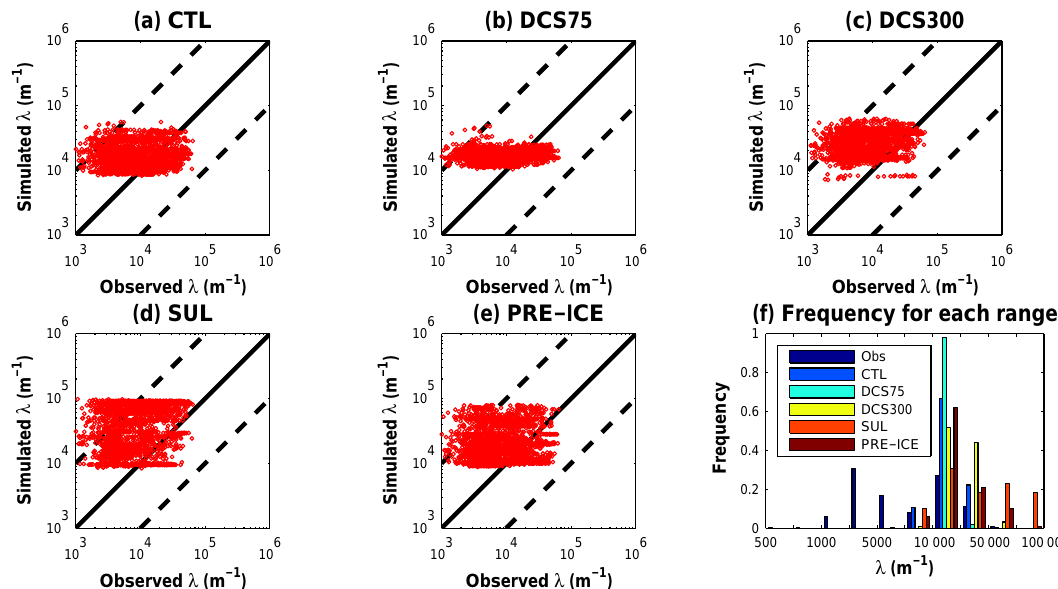
Figure 6. (a–e) Scatterplot of observed versus simulated slope parameter ( λ) of the gamma size distribution function for each experiment, and (f) the frequency of λ for each range. Note that all the comparisons are restricted to the cases when the model captures observed ice clouds ( T ≤ − 40 ◦